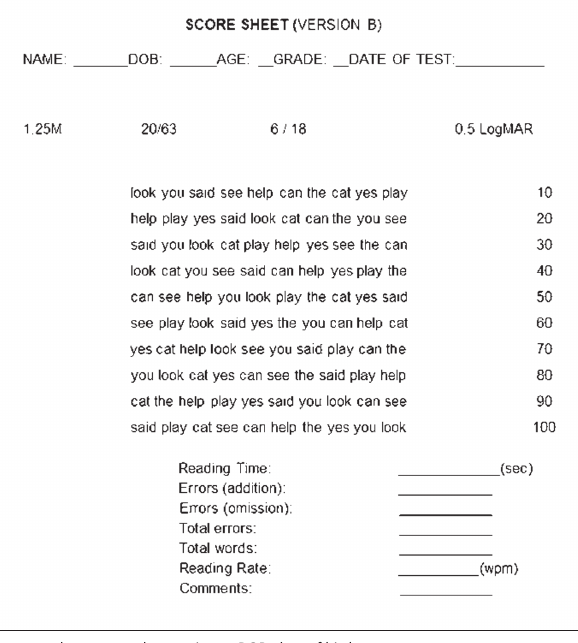
sec, second; wpm, words per minute; DOB, date of birth. FIGURE 3: Version B score sheet of the paediatric rate of reading chart.